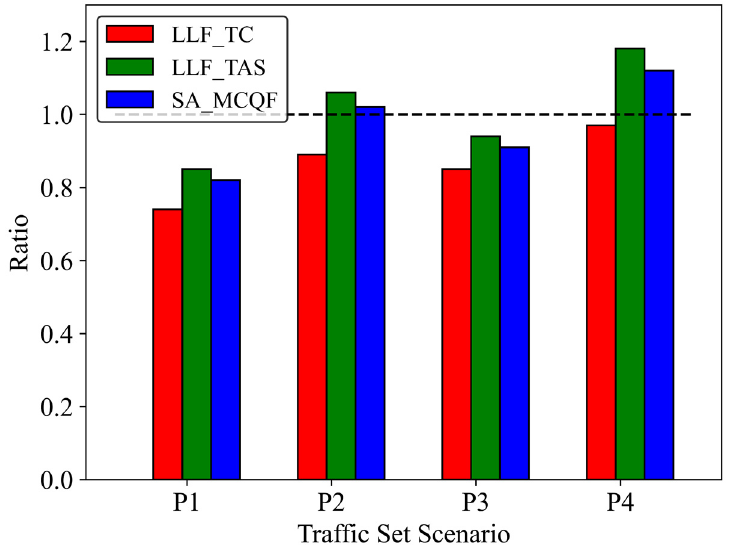
Figure 10. Ratio of average end-to-end delay to average deadline of RC traffic in different traffic scenarios.